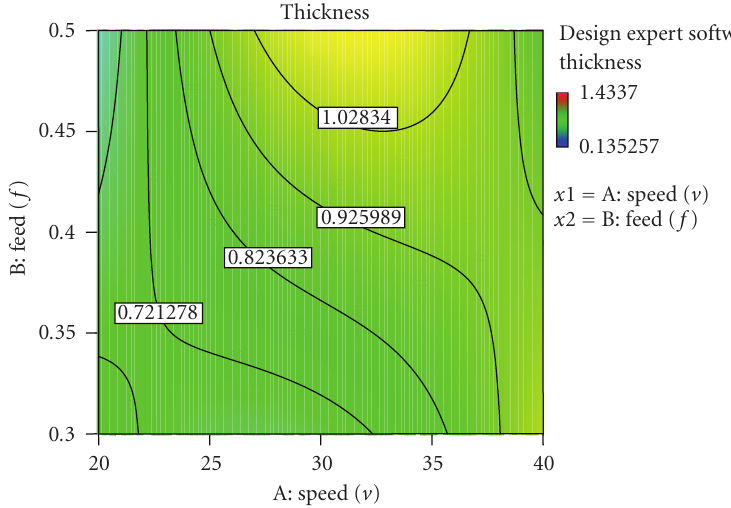
Figure 6.3 . Contour graph of chip thickness as a function of speed and feed.